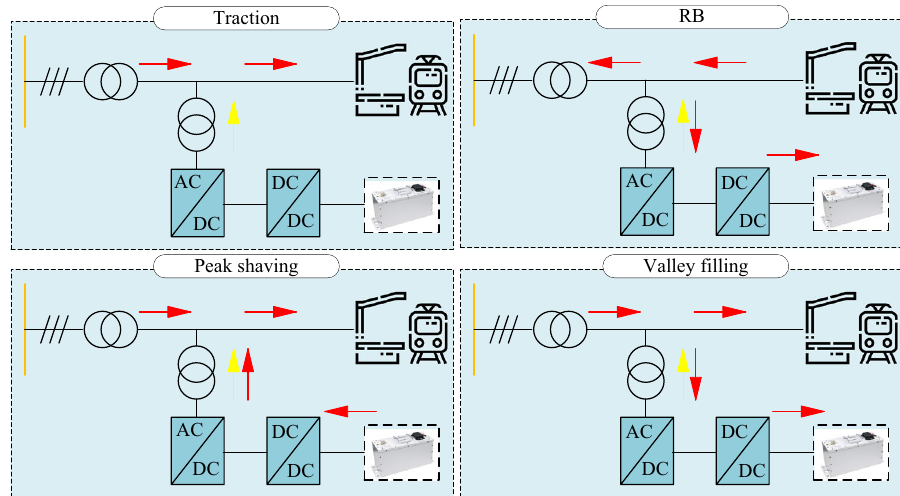
Fig. 6 Power flow and compensation direction